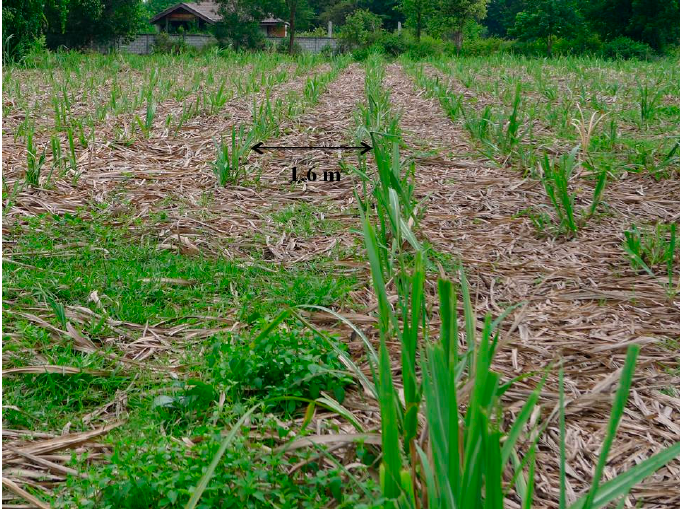
Figure 1. Sugarcane leaves and residues after harvesting.